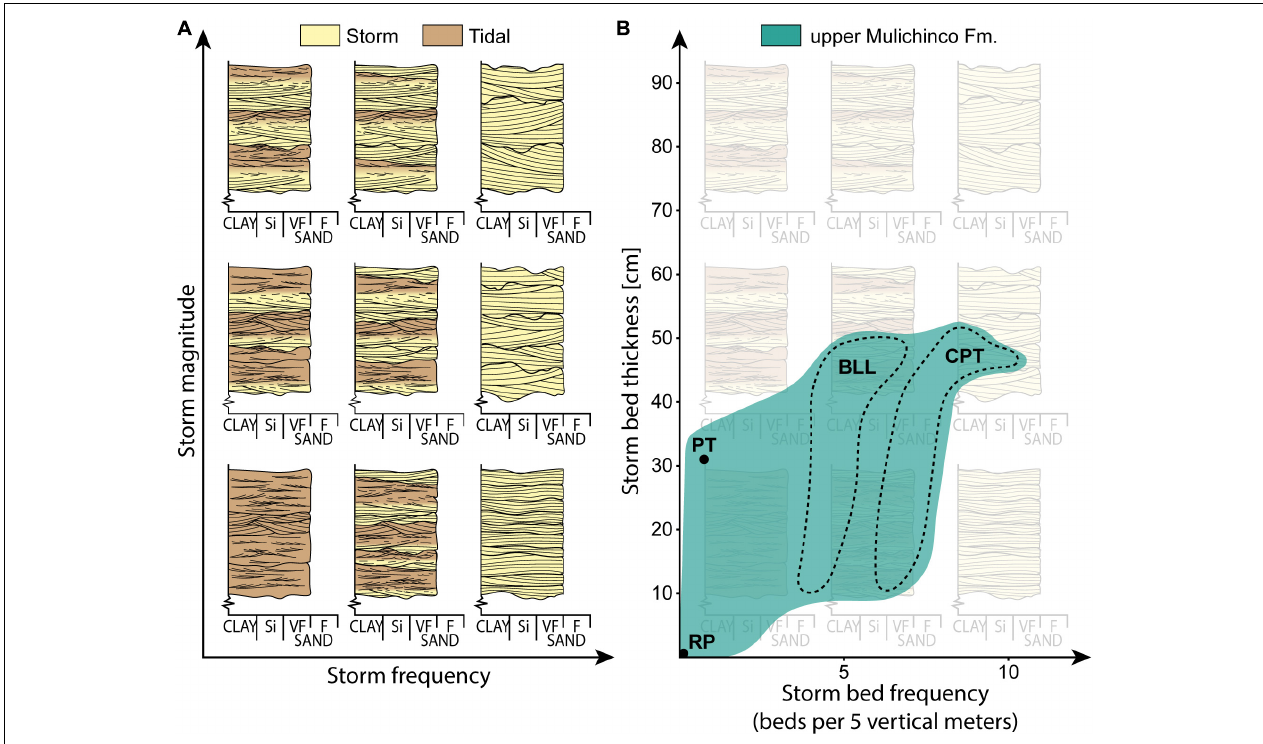
FIGURE 13 | (A) Sketch diagram showing depositional signature as an effect of variations in storm frequency ( x -axis) and magnitude ( y -axis), relative to constant tidal energy and subsidence rate. (B) Data from the upper Mulichinco Fm. FA3 deposits, from the focus interval ( Figure 10 ), black circles and dotted lines indicate data from measured sections, and teal (blue-green) color indicates approximate data from VOMs. CPT, Cerro Pampa Tril; PT, Pampa Tril; BLL, Barranca Los Loros; RP, Río Pequenco ( Figure 1D